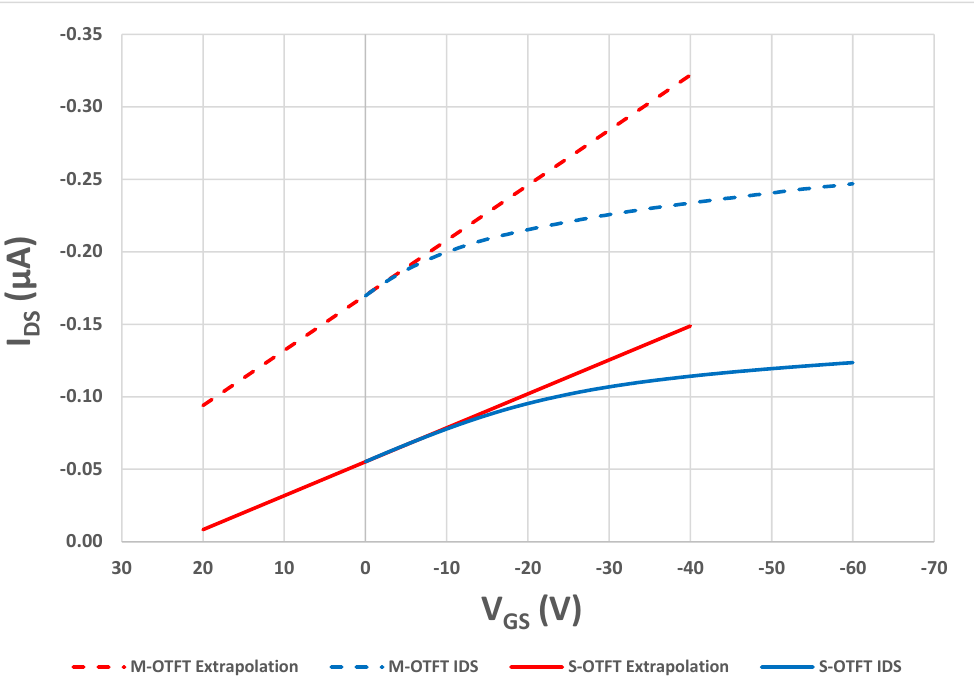
Figure 3. Transfer characteristics of a standard and modified OTFTs at V DS = − 5 V, along with the linear extrapolation of the curves at maximum transconductance. The solid lines are for a S-OTFT and the broken lines are for a M-OTFT.